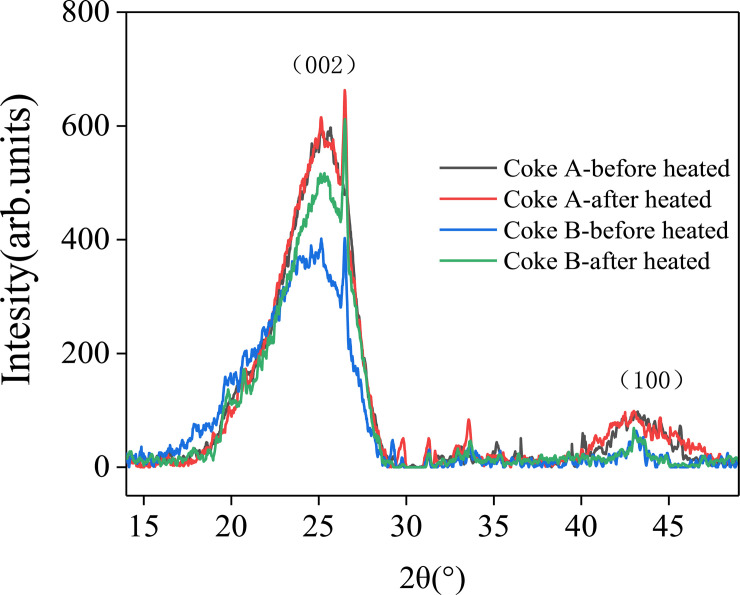
XRD spectra of coke.